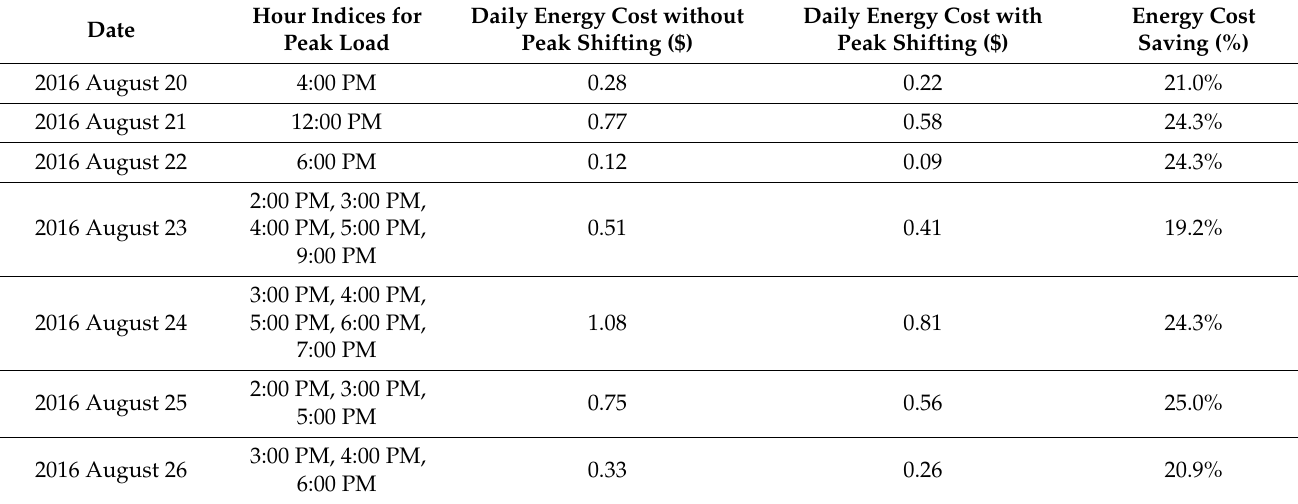
Table 4. Peak load identification and energy cost saving in a